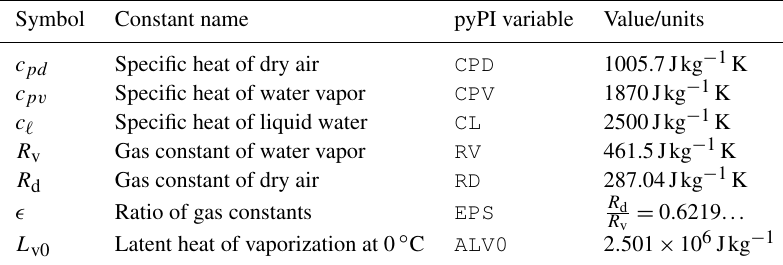
Table A1. Meteorological constants used in the potential intensity algorithm.